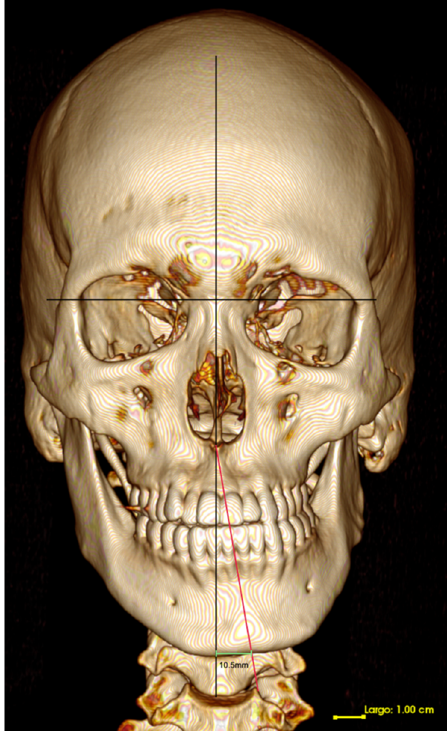
Figure 4 . Bone tissue CT, 3D reconstruction. Coronal view. Mandibular deviation magnitude and deviation side.